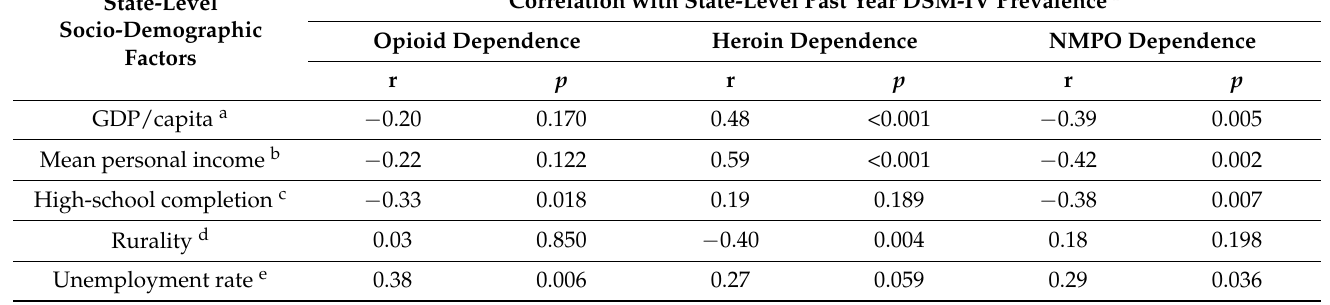
Table 1. Correlations between state-level socio-demographic factors and state-level prevalence of